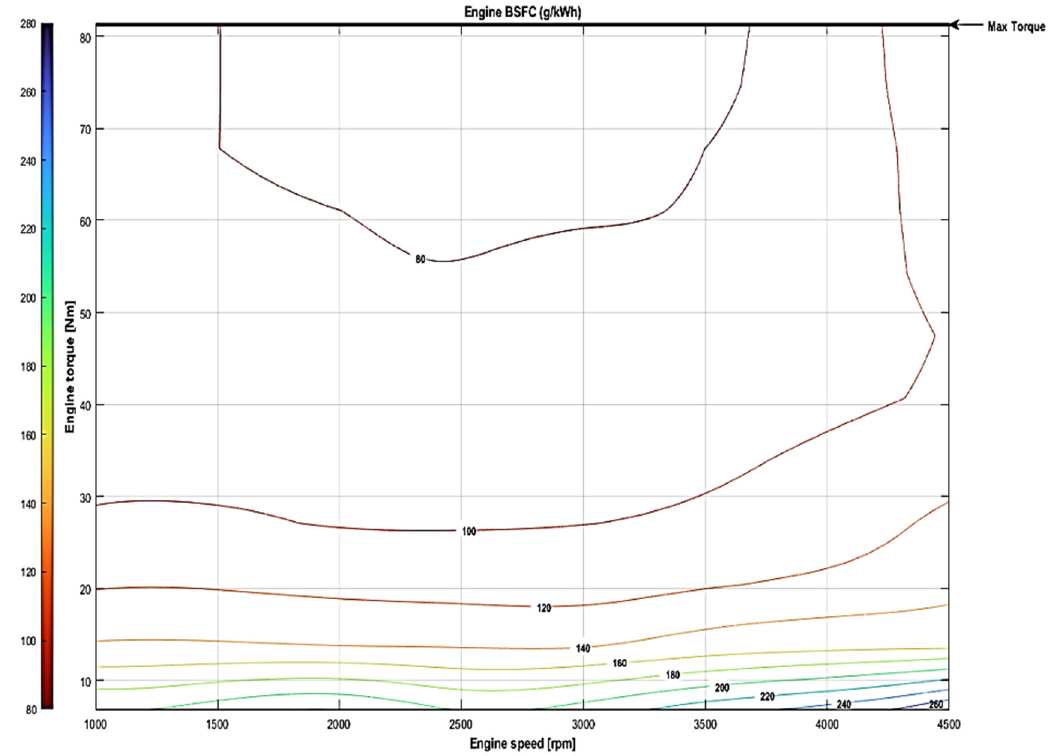
Figure 2. BSFC map of ICE engine.